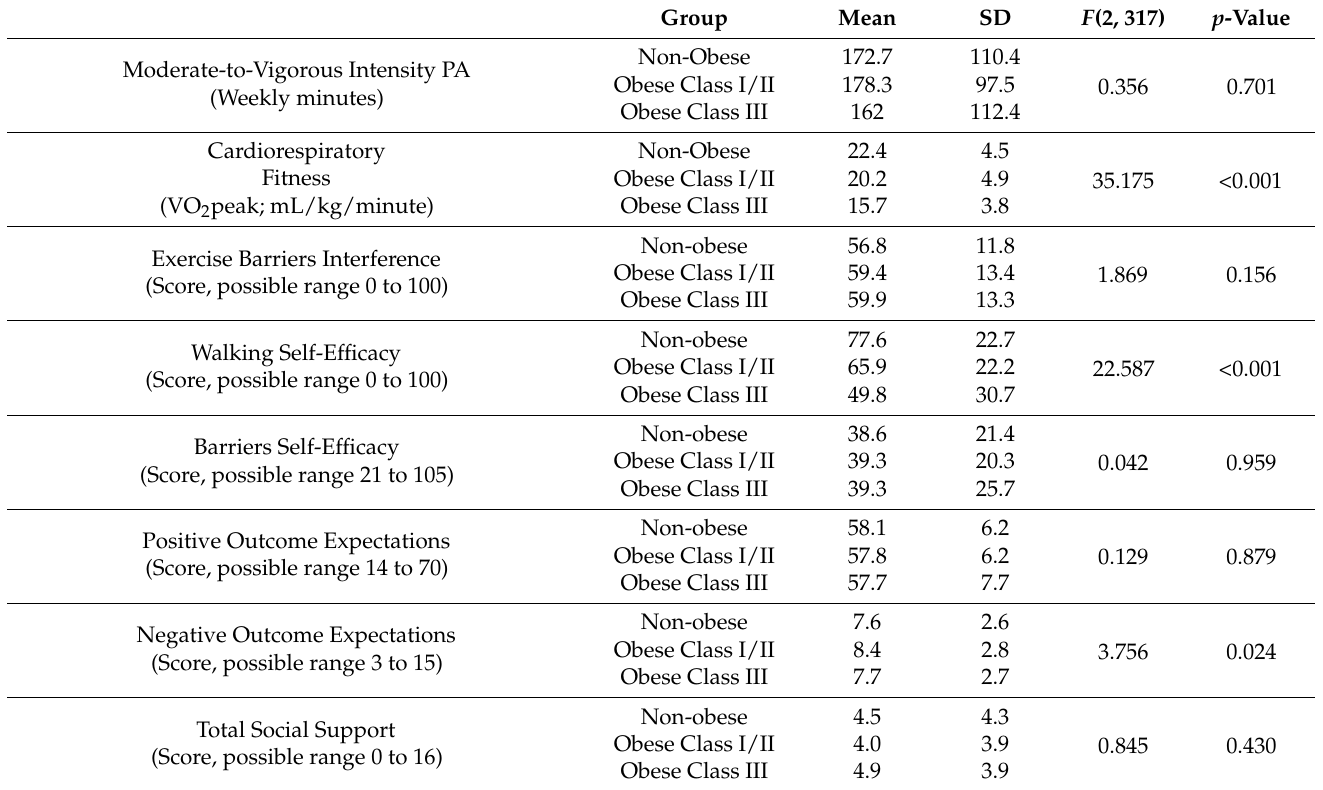
Table 2. Differences in moderate-to-vigorous intensity PA, cardiorespiratory fitness, and SCT vari- ables between the three levels of BMI.